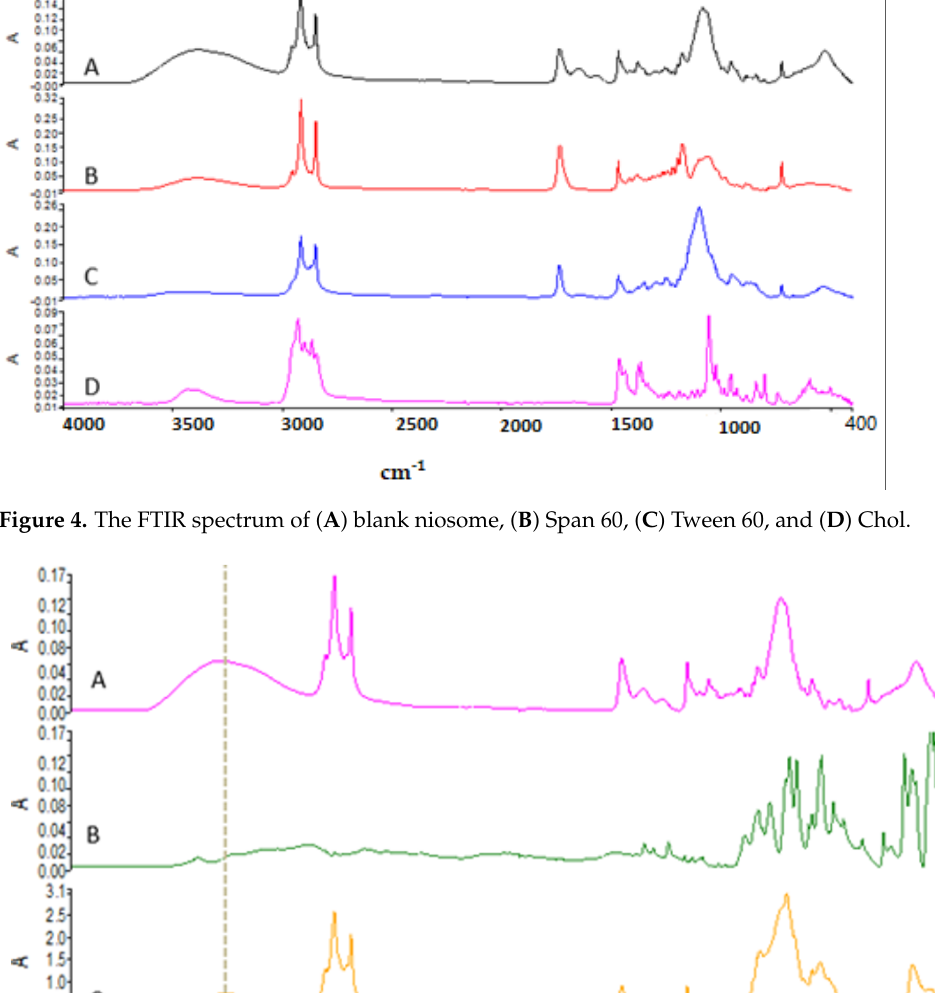
Table 5. Short-term stability study results for F4, F6, and F10 at 4 °C after one and two months. Results are represented by mean ± SD ( n =